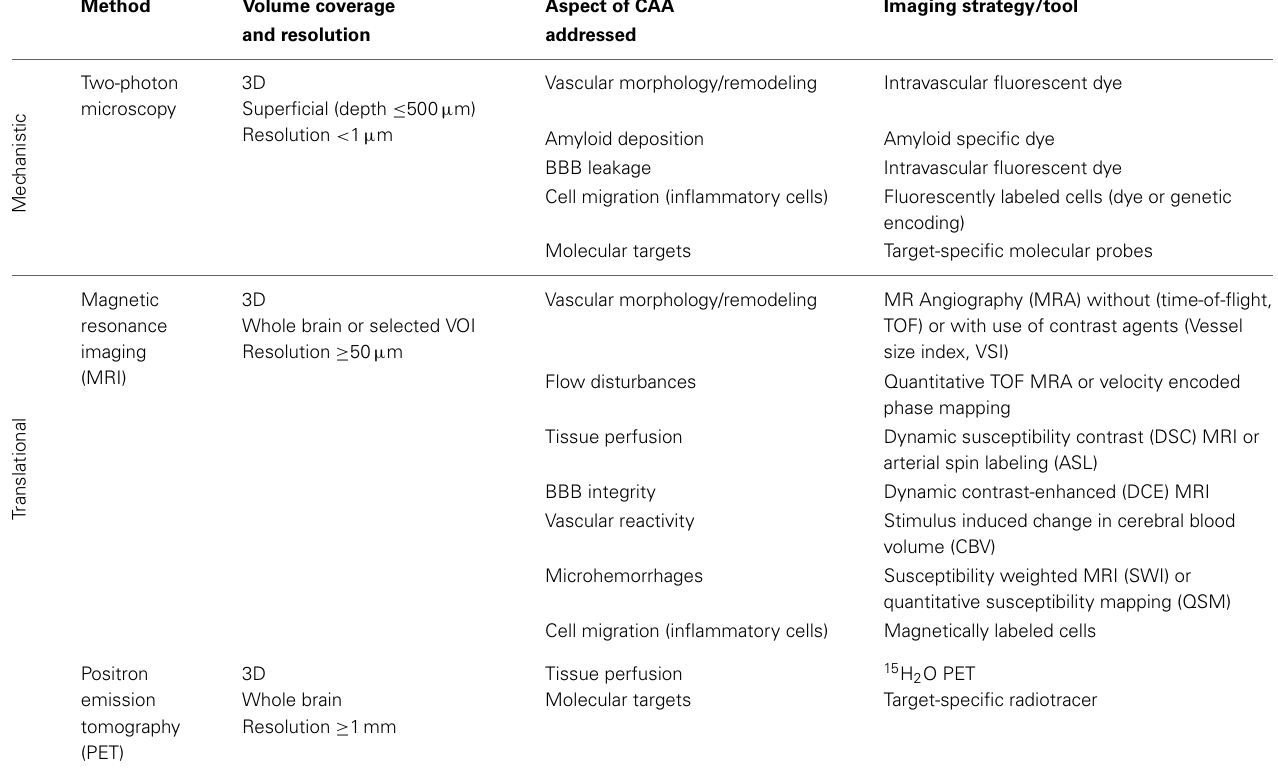
Table 2 | In vivo imaging techniques applied to AD